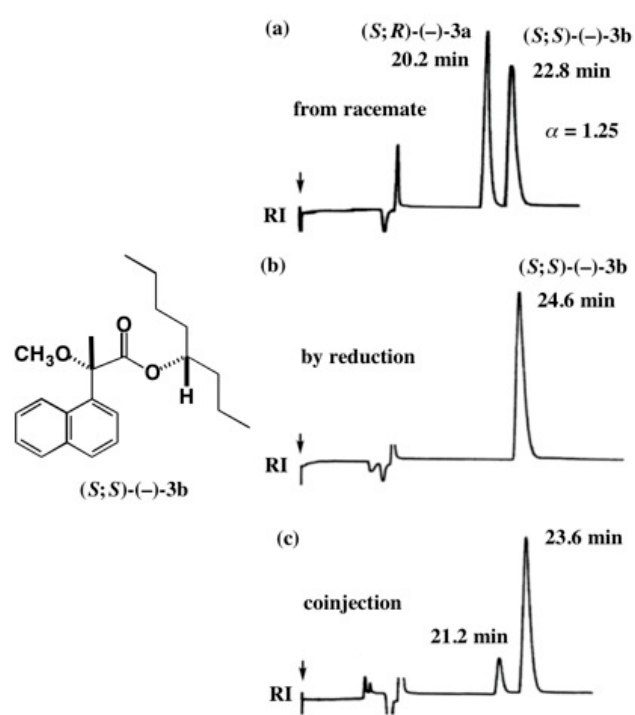
Figure 52. Diastereomeric purity check of M α NP ester ( S ; S )-( − )- 3b obtained by the catalytic reduction of acetylene alcohol M α NP ester ( S ; S )-( − )- 70a . HPLC, hexane/EtOAc 20:1. ( a ) ( S ; R )-( − )- 3a and